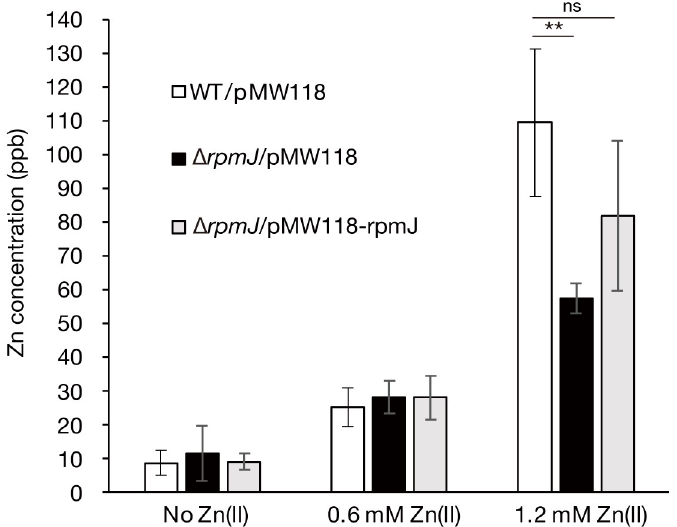
Fig 4. The intracellular zinc(II) concentration in the rpmJ mutant is low under excess zinc conditions. Wild-type E . coli strain transformed with an empty vector (WT/pMW118), the rpmJ mutant transformed with an empty vector ( Δ rpmJ /pMW118), the rpmJ mutant transformed with a plasmid carrying an intact rpmJ gene ( Δ rpmJ /pMW118-rpmJ) were cultured under conditions of 0 mM Zn(II), 0.6 mM Zn(II), and 1.2 mM Zn(II), added 1 mM IPTG. The zinc concentration was measured by ICP-MS. Data shown are means ± standard deviation from 4 independent experiments. �� p <